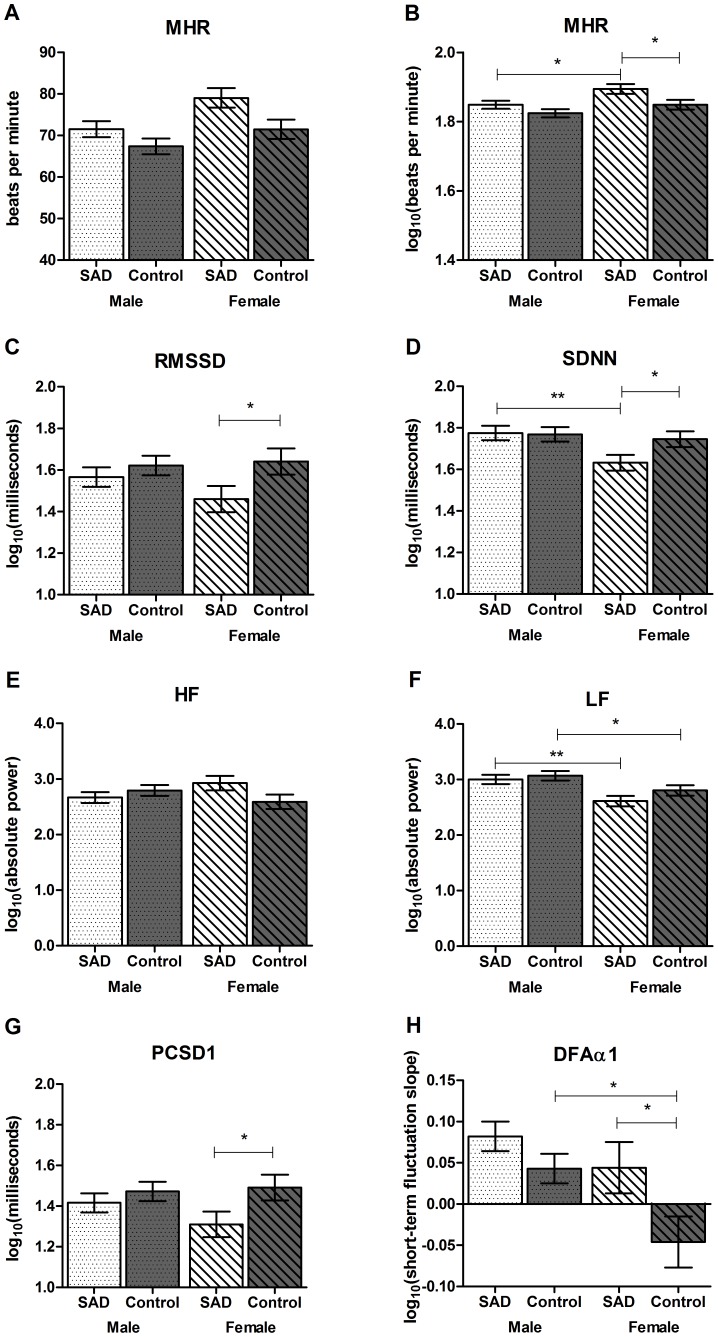
Comparison of resting heart rate variability between males and females with social anxiety, compared to controls, across mean heart rate (row 1), as well as time (row 2), frequency (row 3), and non-linear (row 4) domains.
Note. All variables are log-transformed (base 10), except for A (which depicts untransformed beats per minute). Error bars depict standard error of the mean. Significance taken from multivariate analysis of variance with group and gender entered as between subjects variables. Significance tests were not conducted on untransformed mean heart rate. MHR = mean heart rate, beats/min, SDNN = standard deviation of all R-R intervals, RMSSD = square root of mean squared differences of successive R-R intervals, LF = low frequency, HF = high frequency, PCSD1 =  standard deviation of the Poincaré plot perpendicular to the line of identity, DFAα1 =  detrended fluctuation analysis of the short-fluctuation slope. *p<.05, **p<.01.